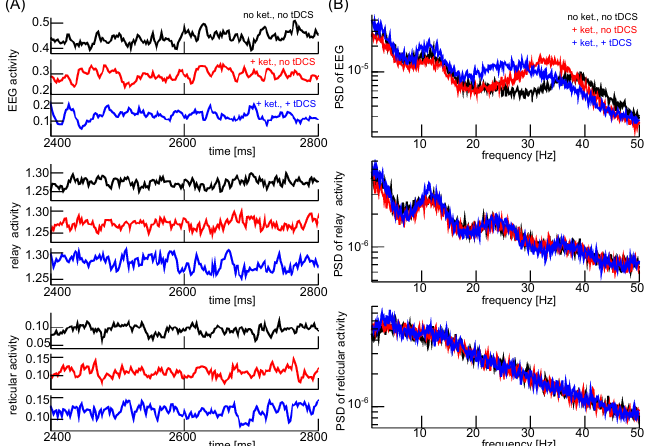
Figure 6. Cortical and subcortical activity under ketamine and anodal tDCS. ( A ) Model activity time courses of EEG (upper panels), relay cell population (center panels) and reticular cell population (lower panels) under different conditions. ( B ) Power spectral density distributions of EEG (top panel), relay cell population panel (center panel) and reticular cell population (bottom panel). Parameters are f tDCS = 1.05 corresponding to stimulation duration of 4 min with τ plast = 1 min, f ketamine = 0.7 = 2.0 in SG layers. in the cortico-thalamic loop and f ketamine = 0.8, f resp tDCS